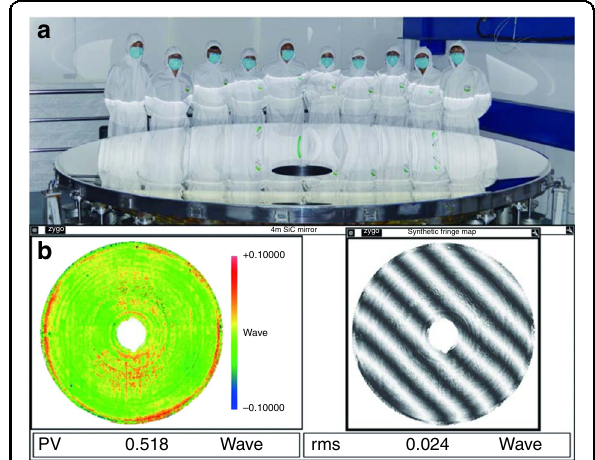
Fig. 1 Four meter SiC aspheric mirror manufacturing results. a Picture of the 4 m SiC aspheric mirror. b Test result and interferogram of the ⌀ 4 m SiC aspheric mirror. Adapted with permission from ref. 10 , Springer